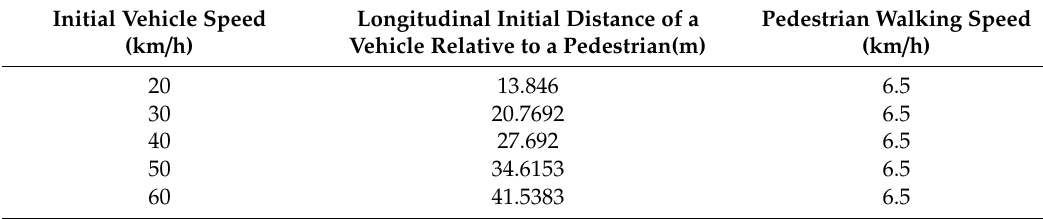
Table 11. The CVFA-50 simulation